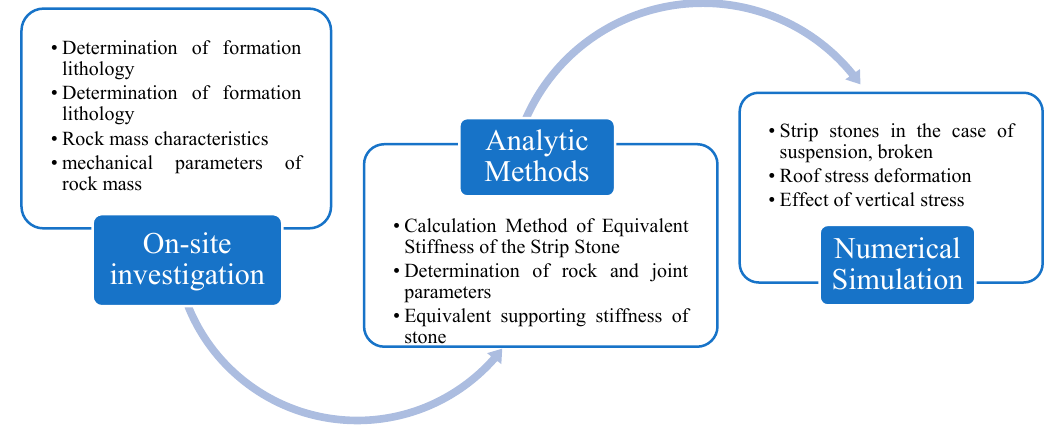
Figure 4. Flow chart showing the available data and methods used in this study.